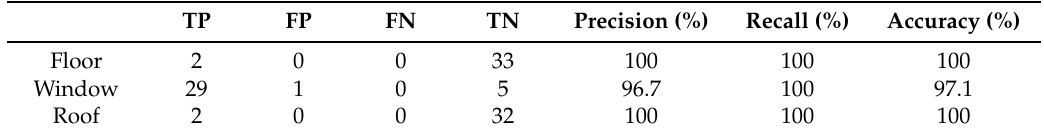
Table 6. Evaluation of semantic recognition for case study 1.